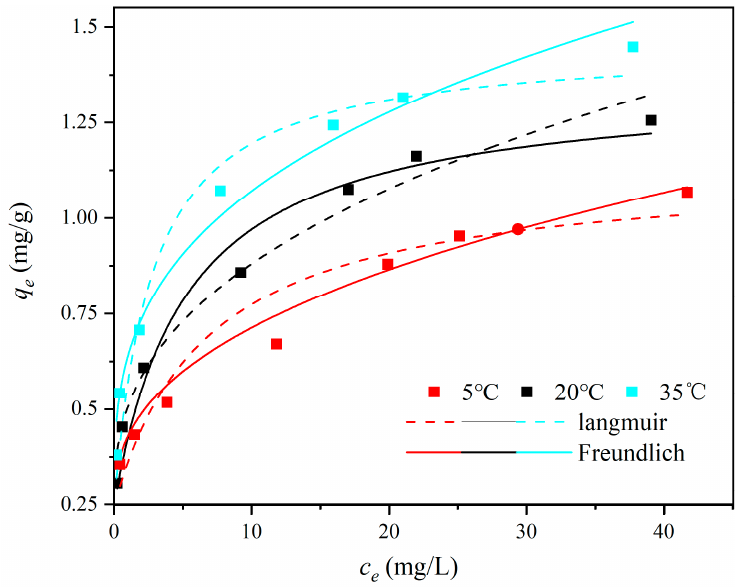
Figure 10. Adsorption isotherm models of bio-ceramsite at different temperatures. Table 4. Parameters of adsorption isotherm models of bio-ceramsite at different temperatures.